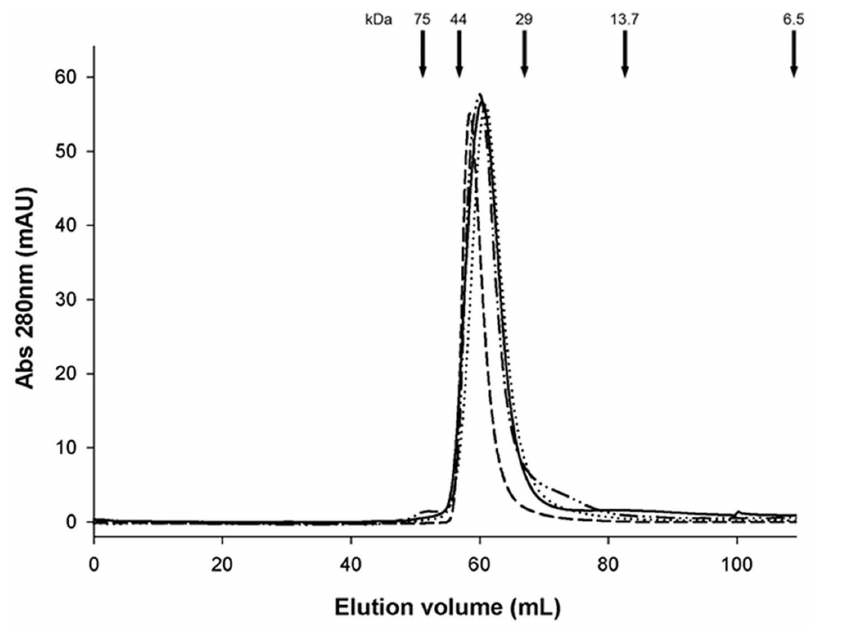
Figure 4. Size exclusion chromatography of rLC. rAL-1 (dotted), rAL-2 (short dashes), rAL-3 (dash-dot-dot) compared with AL-2 BJ protein (solid). Conalbumin (75.0 kDa), ovalbumin (44.0 kDa), carbonic anhydrase (29.0 kDa), ribonuclease A (13.5 kDa), aprotinin (6.5 kDa) were used as molecular mass standards. Virtually identical elution profiles were observed.